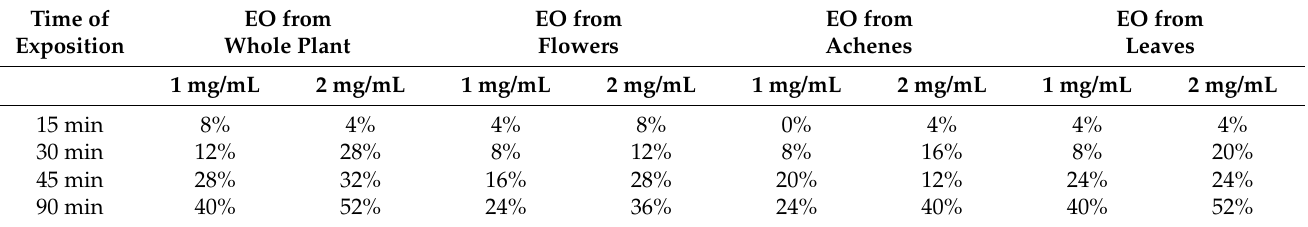
Table 2. Mortality percentages obtained after 15, 30, 45 and 90 min of exposure to EO